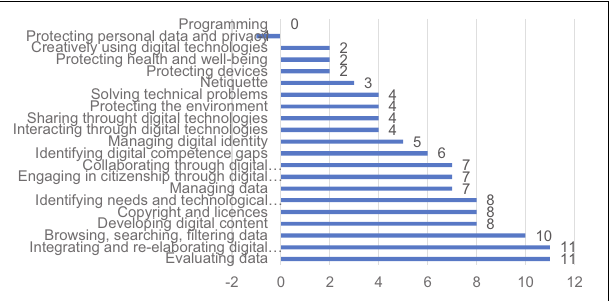
FIGURE 3 | Differences in the digital literacy status between librarian graduates and non-librarian graduates at the advanced and highly specialized